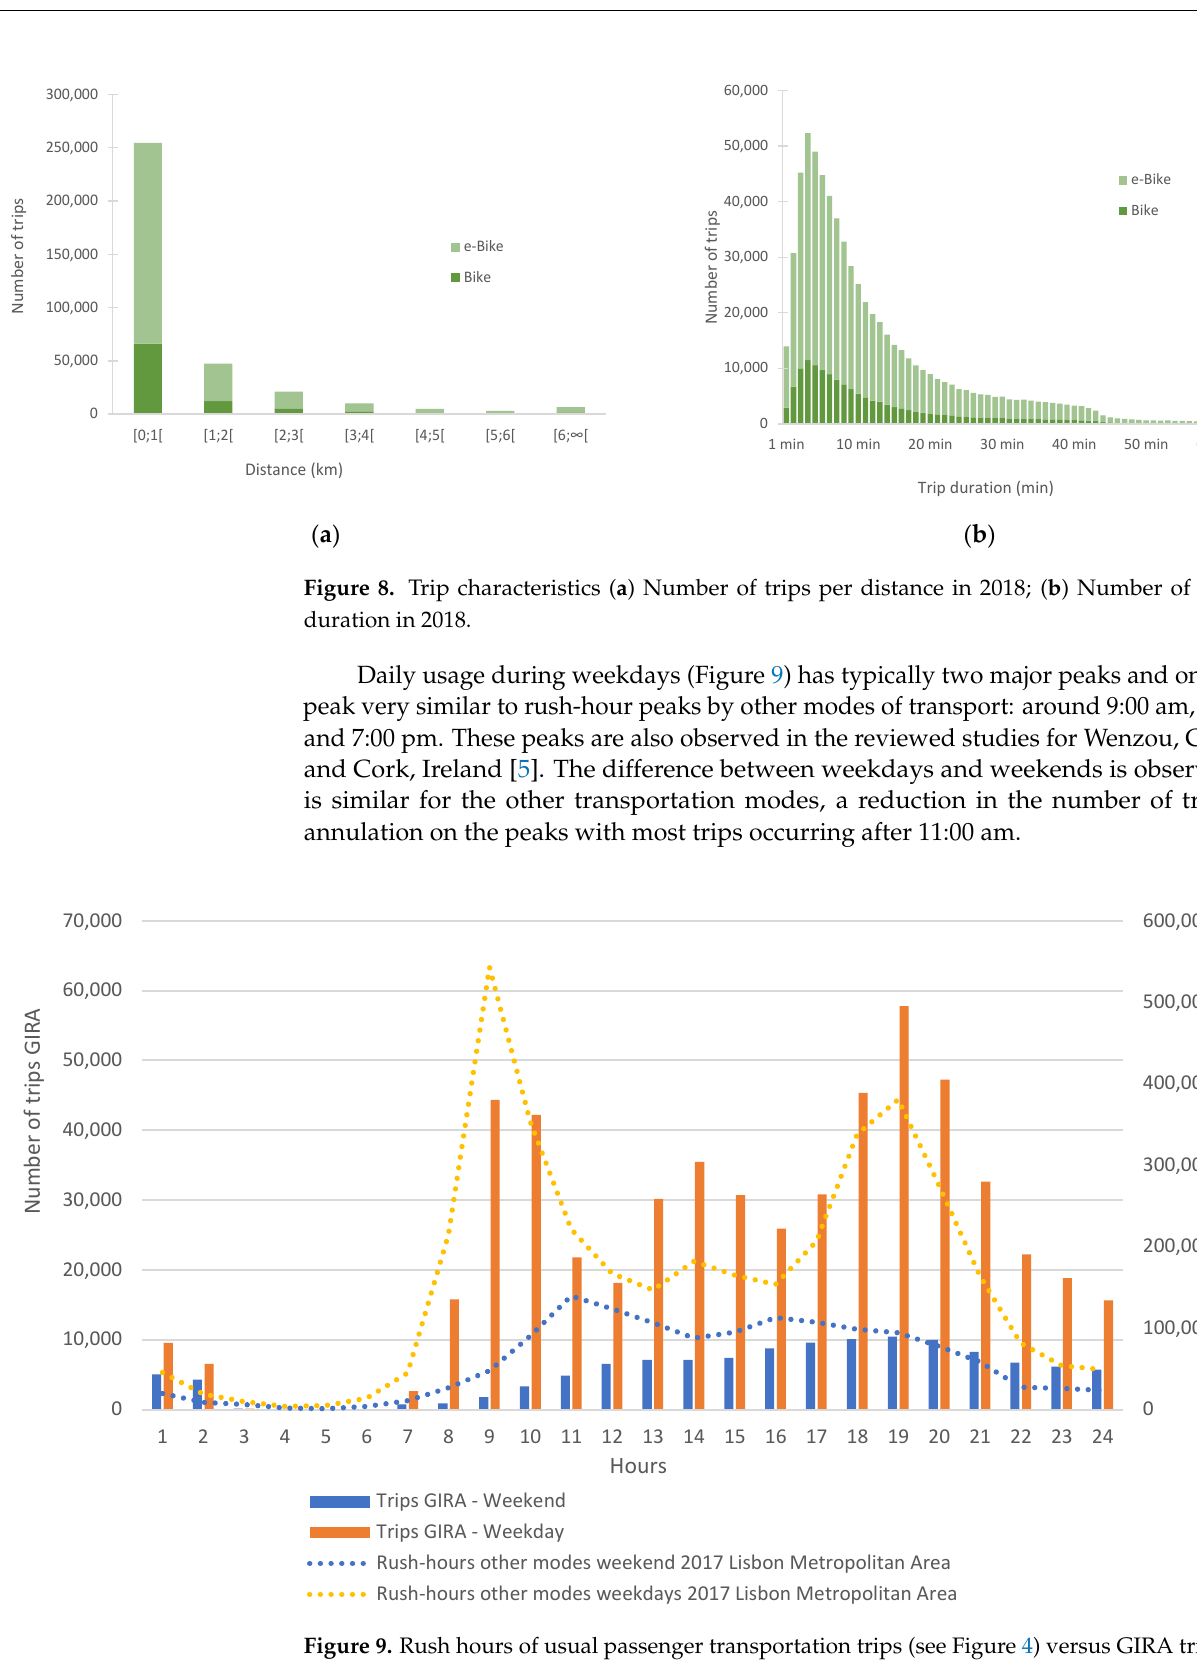
Figure 7. GIRA trips and average trips per bike in the implementation year, 2017, and first year of operation, 2018.